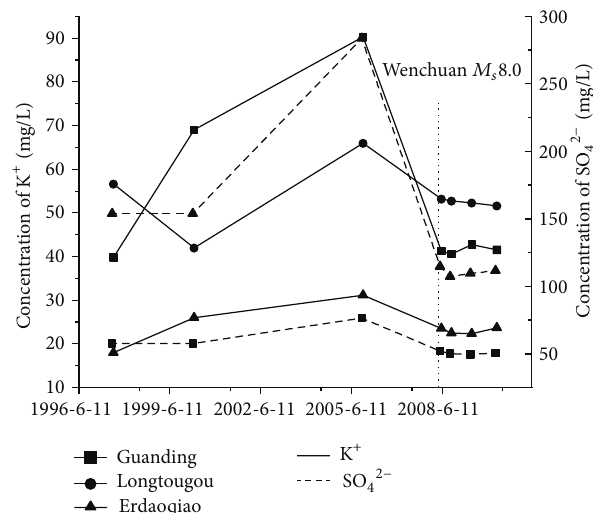
Figure 5: Temporal variations of concentration of K + and SO 4 2− . Black squares: waters collected from the Guanding spring; black cycles: waters collected from the Longtougou spring; black triangles: waters collected from the Erdaoqiao spring; the dashed vertical line: the time of the occurrence of the Wenchuan